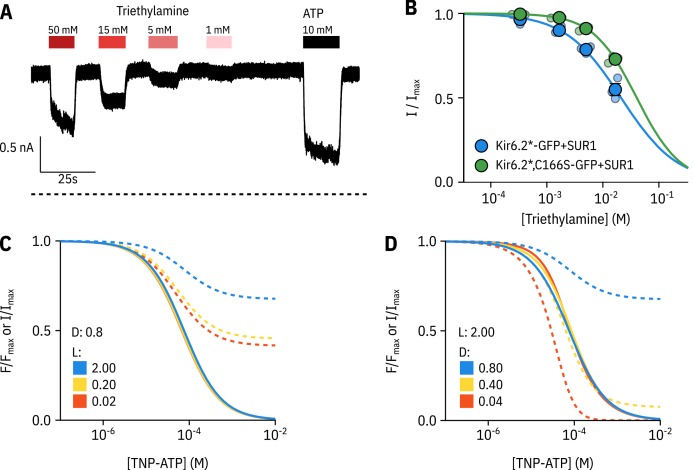
AN MWC-type model predicts a nucleotide-insensitive current plateau for Kir6.2-C166S.A. Representative current trace from an excised patch expressing Kir6.2*,C166S-GFP + SUR1 exposed to triethylamine (shown as shades of red) and 10⁢mM ATP (shown in black). B. Concentration dependence of triethylamine inhibition for Kir6.2*-GFP + SUR1 (blue data points) or Kir6.2*,C166S-GFP + SUR1 (green data points) in excised patches. The solid curves are descriptive Hill fits to the data with 1-Im⁢a⁢x set to 0. Kir6.2*-GFP + SUR1: IC50=63.1mM, h=0.87, n = 3, Kir6.2*,C166S-GFP + SUR1: IC50=120mM, h=1.12, n = 3. (C, D) Predictions of our full MWC-type model for a range of values of L (C) or D (D). Fluorescence quenching (F/Fm⁢a⁢x) is shown as solid curves and current inhibition (I/Im⁢a⁢x) is shown as dashed curves. The blue curves represent values taken from the fit to Kir6.2*,C166S-GFP + SUR1 shown in Figure 3D rounded to the nearest significant figure. Notably, the model predicts that if nucleotide inhibition is shifted to the right of nucleotide binding, we should expect to see a current plateau proportional to the unliganded open probability of the channel.